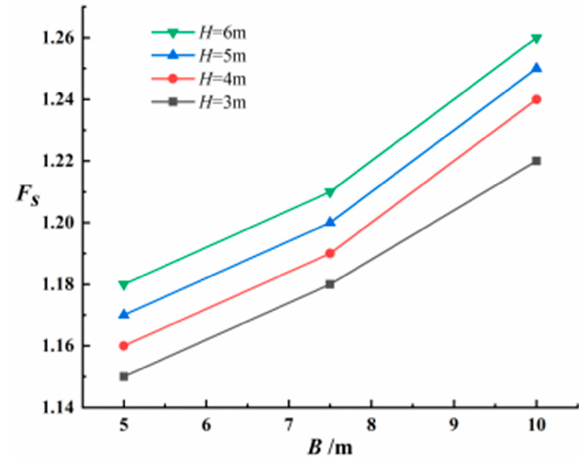
Figure 9. The stability factors of the subgrade with different ELB widths.